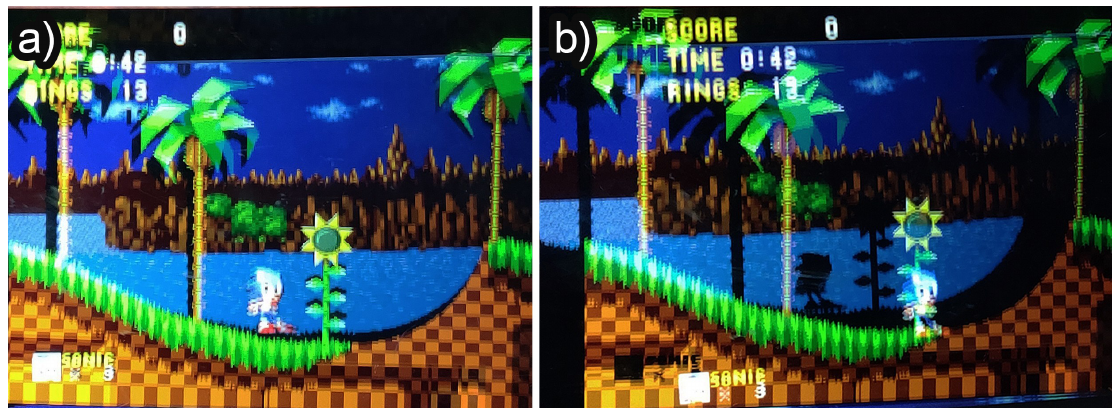
Figure 13. Masking the foreground silhouette in black in background layers. ( a ) observed from the front. ( b ) gaps are revealed when SliceView is observed from a different angle. (Megadrive Sonic the Hedgehog TM ).